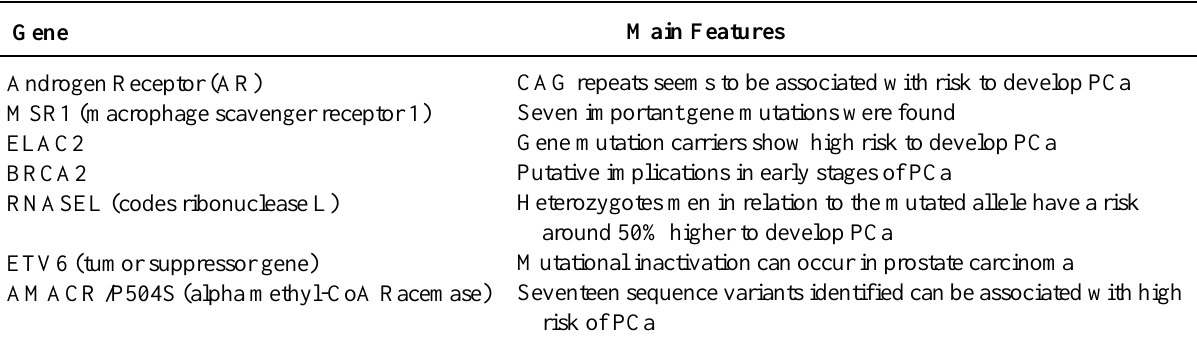
Table 1 – Main susceptibility genes for developing prostate